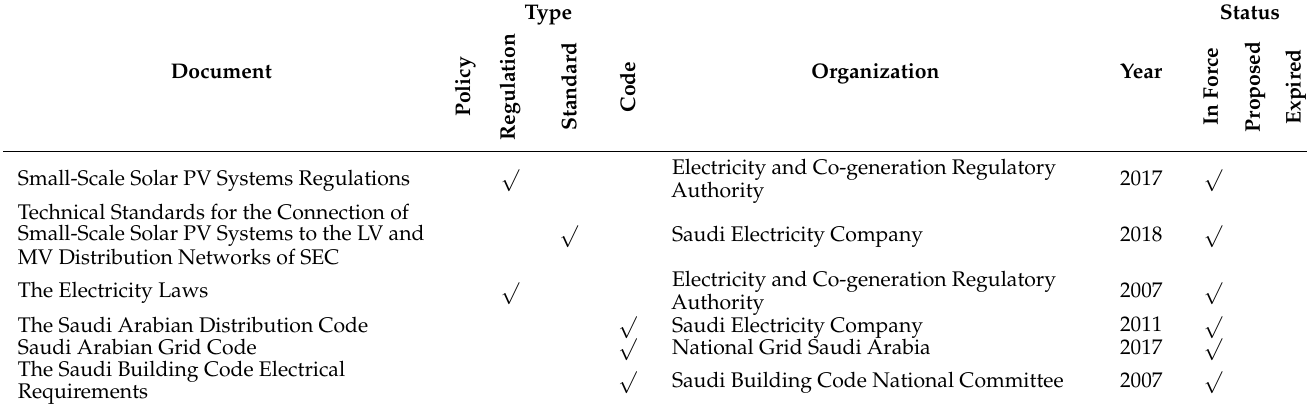
Table 3. RE supporting policies, standards, regulations and codes in the Kingdom of Saudi